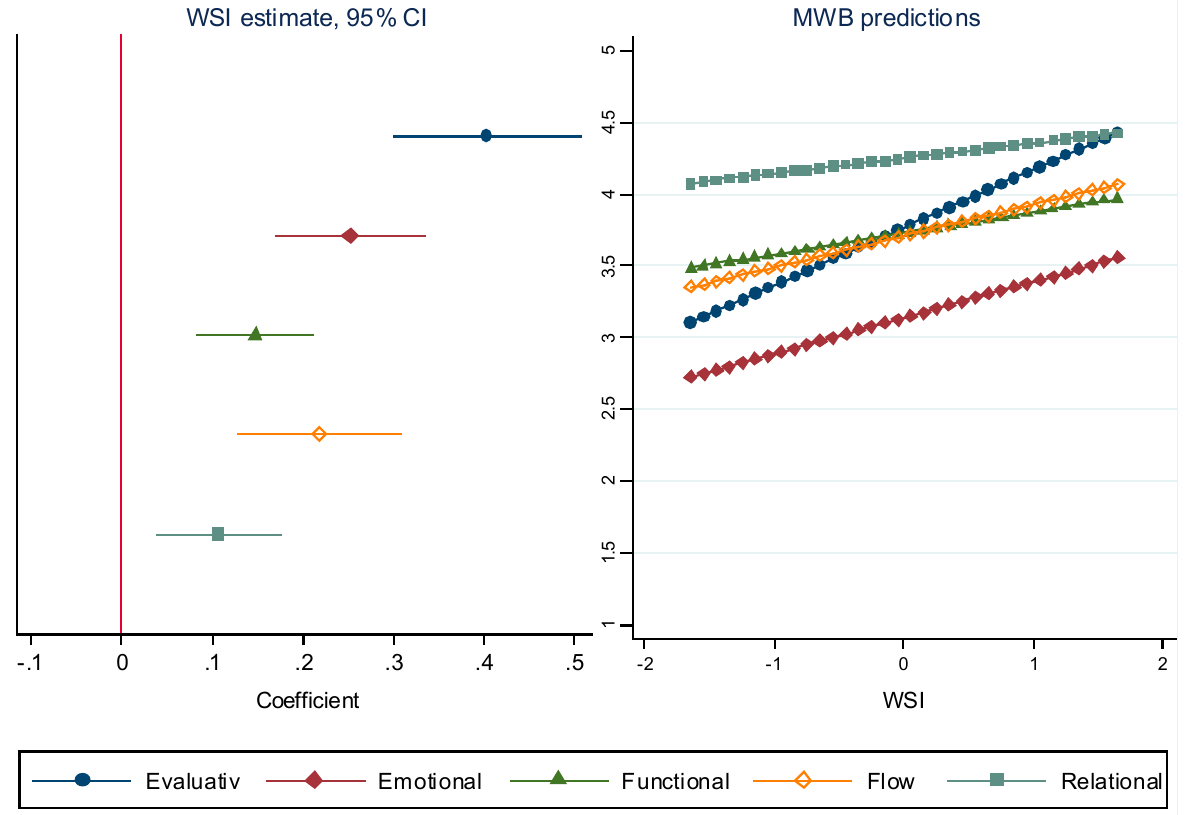
Figure 3. The total effect of WSI on mental wellbeing (coefficient and 95-percent confidence intervals) (left panel) and mental wellbeing-predictions for different values of WSI (right panel).